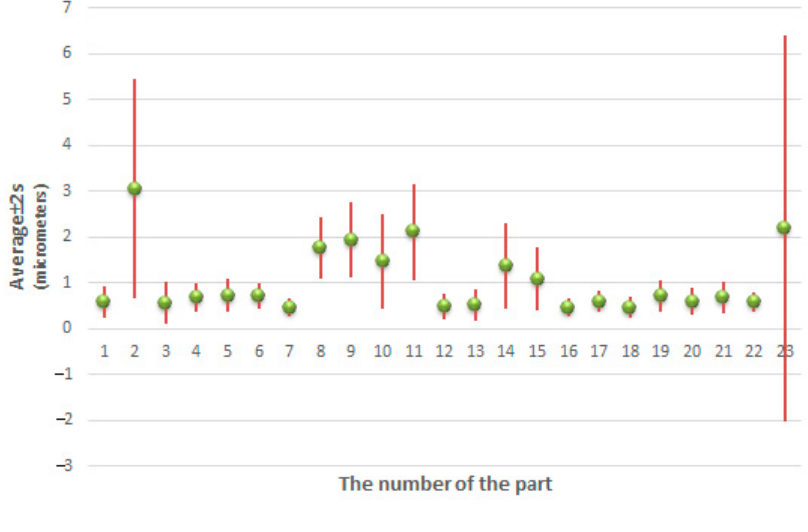
Figure 14. Average values of the roundness deviation and their confidence levels (calculated as ± 2 s ) for each sphere from the second dataset.